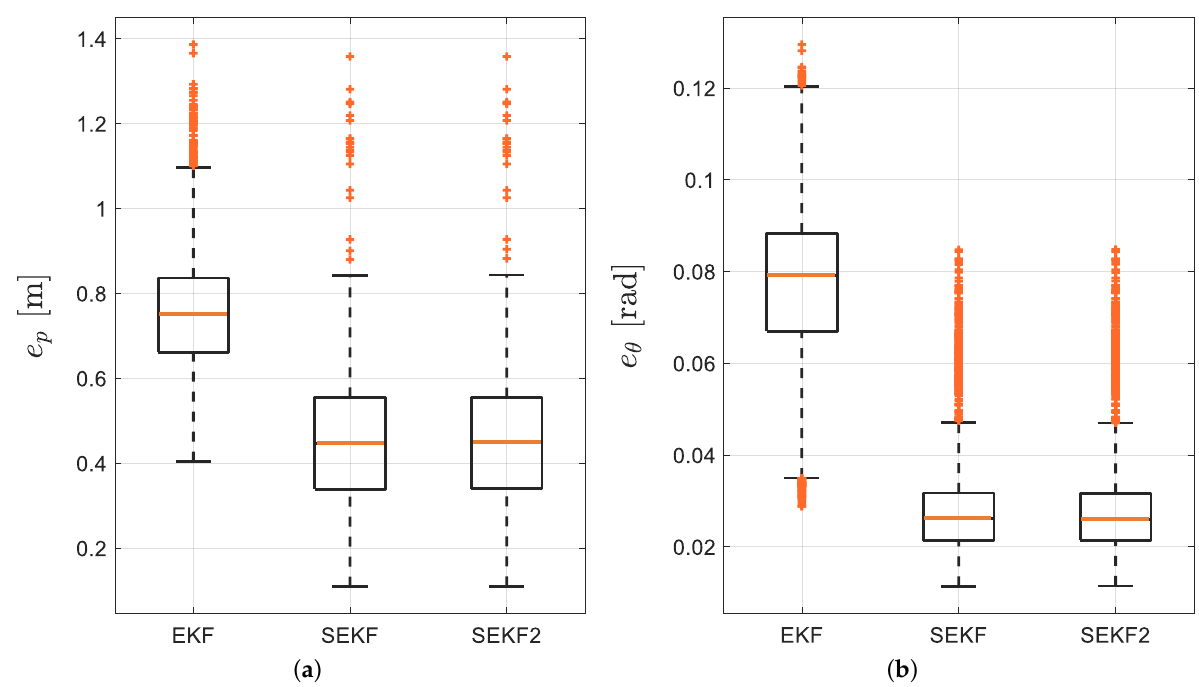
Figure 8. ( a ) Position and ( b ) orientation RMSE box-and-whiskers for EKF, SEKF and SEKF 2 , respectively.